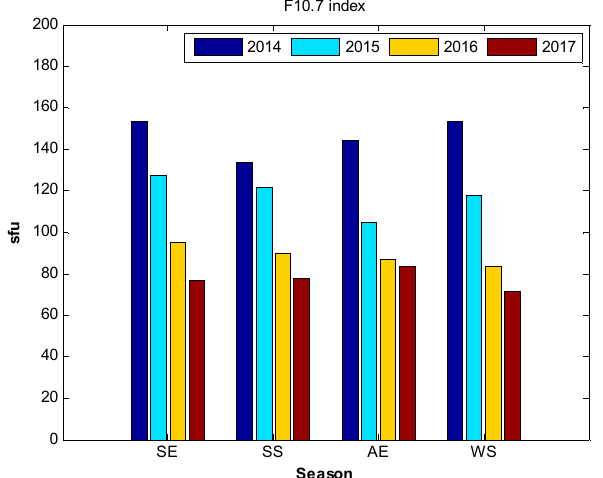
Figure 4. The average solar F10.7 index for different seasons during each year from 2014 to 2017. SE, SS, AE, and WS represent the spring equinox, summer solstice, autumn equinox, and winter solstice, respectively.